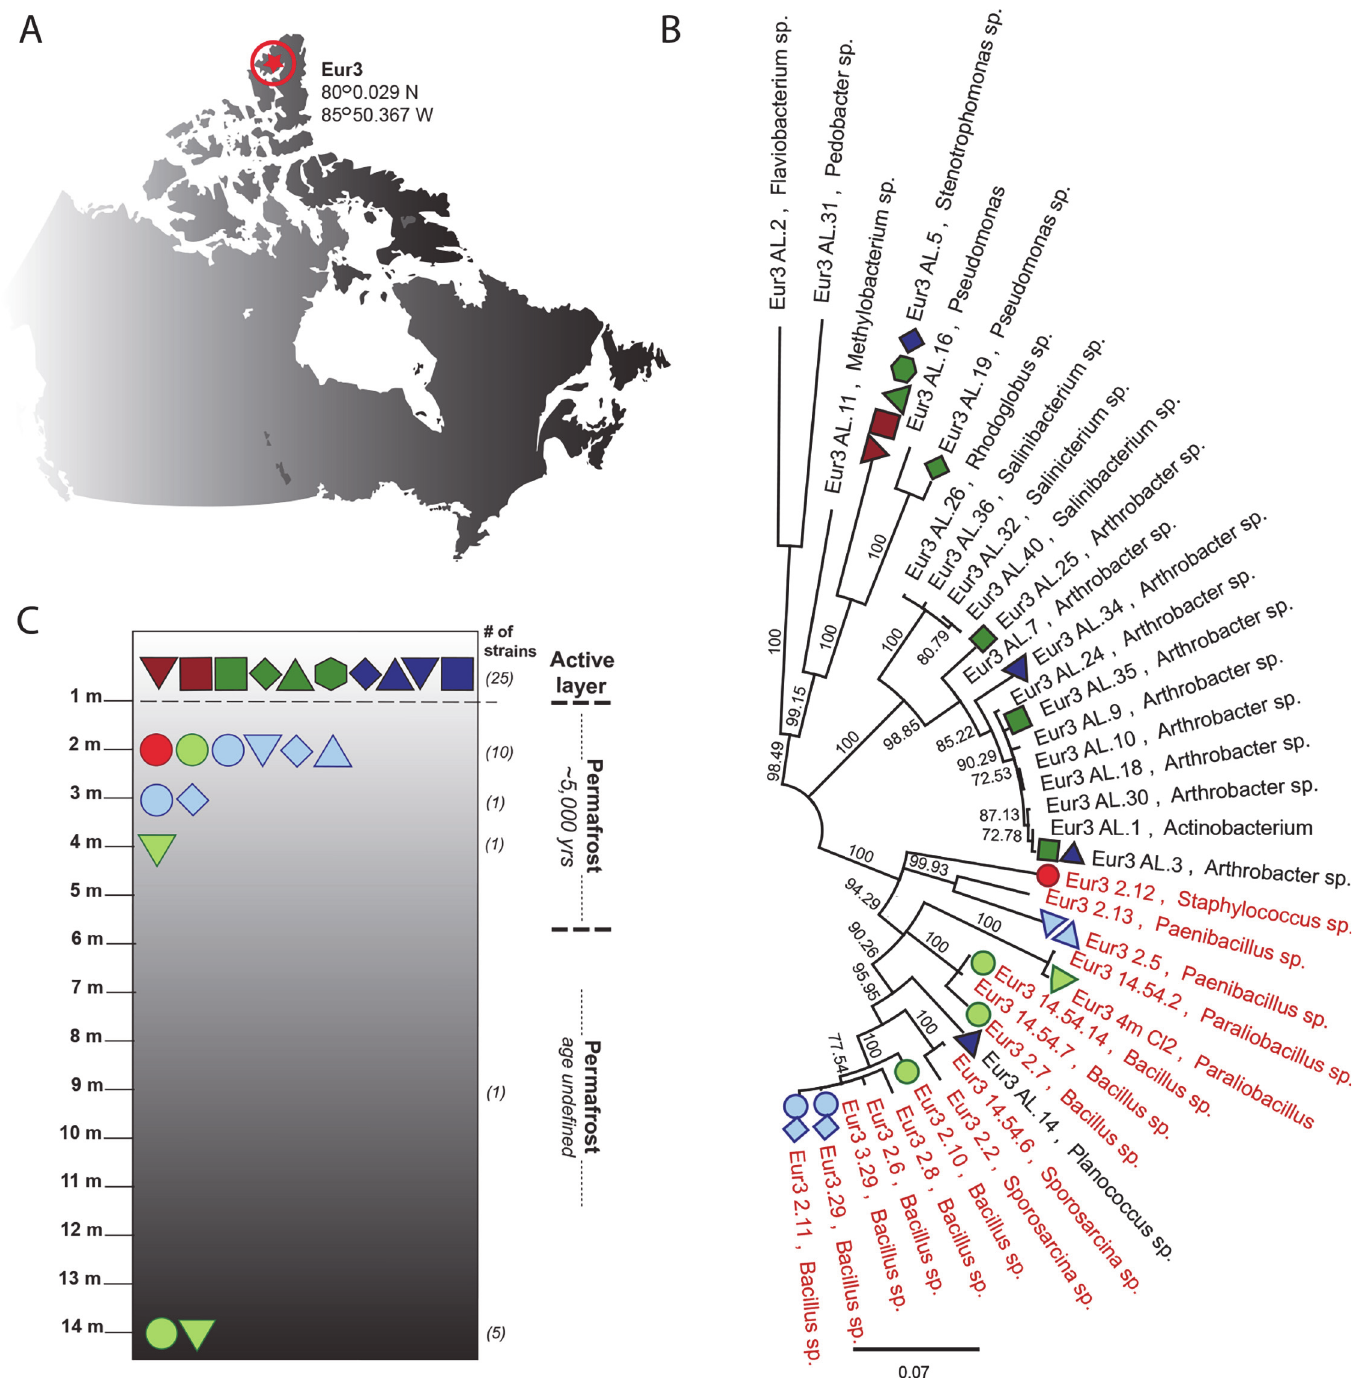
Fig 1. Distribution of antibiotic resistance genes isolated from ancient permafrost bacteria and its overlaying active layer. A) Samples were collected from Eureka on Ellesmere Island, Canada. B) Antibiotic resistance genes isolated using functional metagenomics were traced back to bacterial strains isolated at different depths of a single 14-m core. C) Resistance genes were mapped onto the 16S rRNA gene phylogeny of all ancient (red) and modern (black) bacterial isolates used in this study. Each resistance gene is represented by a unique color and shape combination: resistance to β -lactams (red), tetracyclines (green), and aminoglycosides (blue) as explained in Fig. 2 . We could not identify the host strain for two resistance genes, most likely because we could not revive three ancient strains.